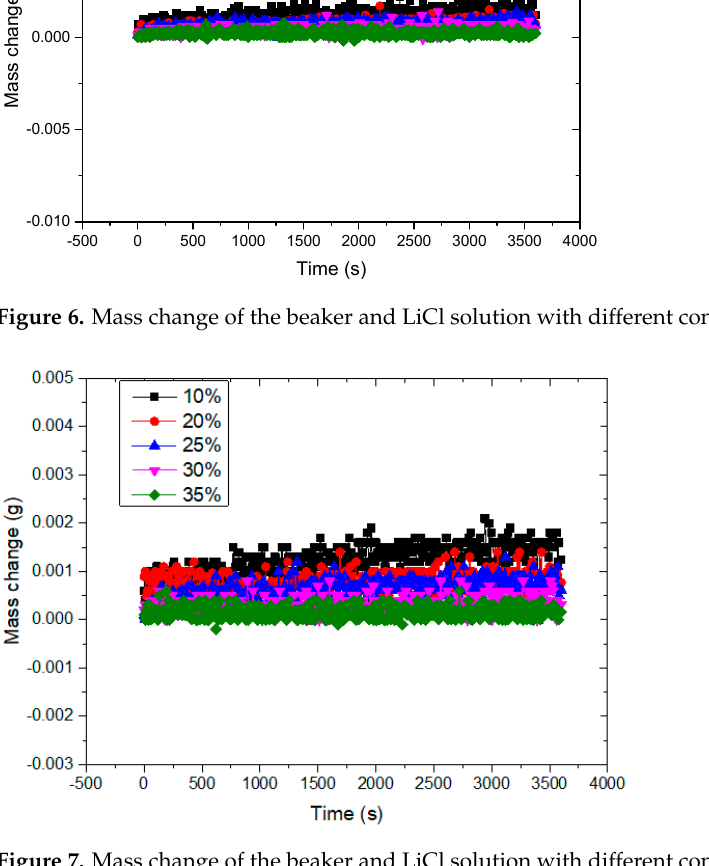
Figure 7. Mass change of the beaker and LiCl solution with different concentrations (30 mL).